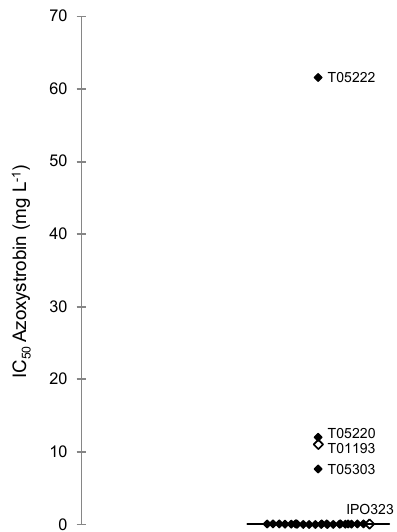
50 values obtained